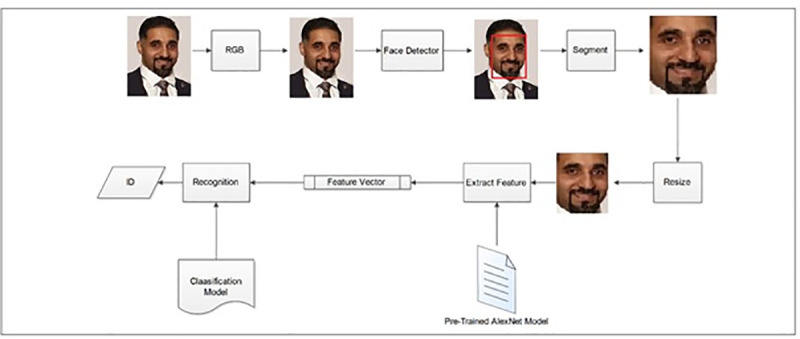
Block diagram of the proposed biometric system (images from dataset published in [18]).